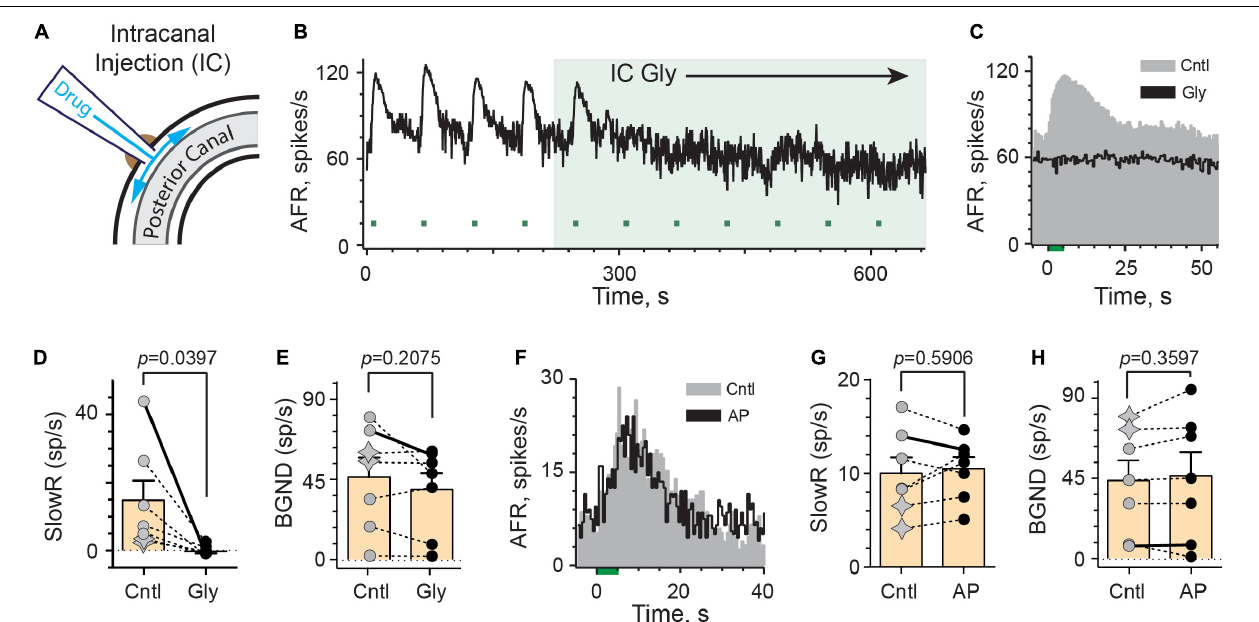
FIGURE 4 | Intracanal application of glycopyrrolate rapidly blocks efferent-mediated slow excitation in mouse vestibular afferents. (A) Our intracanal perilymphatic injection (IC) is made possible by inserting and sealing a small plastic tube within the bony wall of the posterior canal. When connected to a Hamilton syringe, 1–2 µ l volumes can be slowly delivered to the perilymph within the posterior canal to then diffuse to the vestibule and cochlea. (B) Continuous response histogram from an irregular afferent shows changes in afferent firing rate (AFR) during midline efferent stimulation (green bars, 333/s for 5 s every 60 s) before and after perilymphatic injection of glycopyrrolate (1 µ l at 0.5 mM) through the bony posterior canal wall. Glycopyrrolate was slow injected over 30 s starting at t = 220 s (green box). (C) Corresponding average response histograms from the same afferent in (B) were generated separately for the first four and last five efferent shock trains, delivered before (Cntl) and after IC glycopyrrolate (Gly), respectively. (D,E) Values of mean peak slow excitation (SlowR) and background discharge rates (BGND), respectively, during control (Cntl) and IC glycopyrrolate (Gly). Star symbols and filled circles in control column indicate regular and irregular afferents, respectively. Orange bars with error bars reflect the population mean and SEM. Solid line shows values from histograms in (C) . Indicated p -value from paired t -test. (F) Average response histograms for another afferent were generated for efferent shock trains, delivered before (Cntl) and after the IC injection of artificial perilymph (AP). Star symbols and filled circles in control column indicate regular and irregular afferents, respectively. (G,H) Values of mean peak slow excitation (SlowR) and background discharge rates (BGND), respectively, during control (Cntl) and IC artificial perilymph (AP). Orange bars with error bars reflect the population mean and SEM. Solid line shows values from histograms in (F) . Indicated p -value from paired t -test. Binning in (B,C,F) is 500